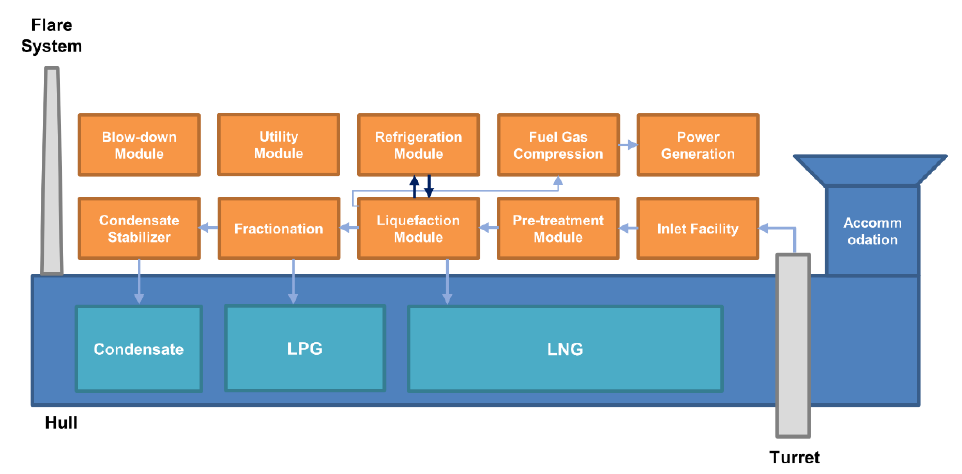
Figure 1. Topside modules of liquefied natural gas—floating production storage and offloading unit (LNG-FPSO).